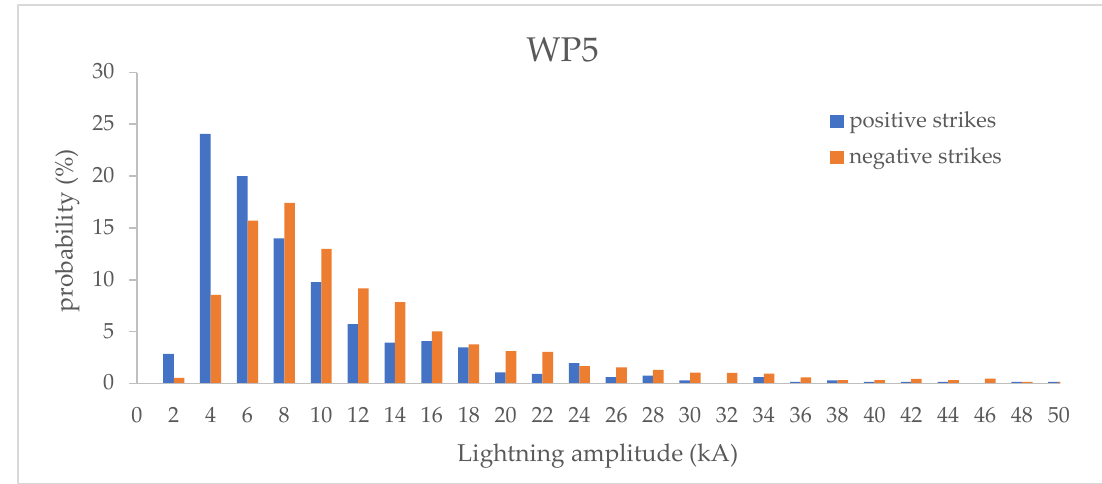
Figure A4. Lightning current amplitude probability distributions for positive and negative strikes extracted from the recorded incidents throughout the period 2011–2020 for WP4.